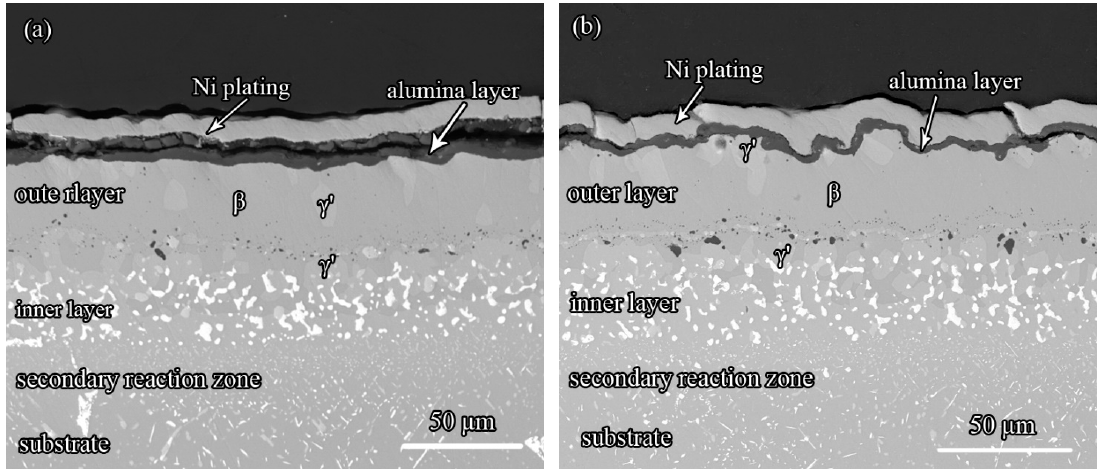
Figure 8. Cross-sectional morphologies of the coatings after oxidation at 1100 °C for 320 h: ( a ) PtAl and ( b ) PtSiAl.